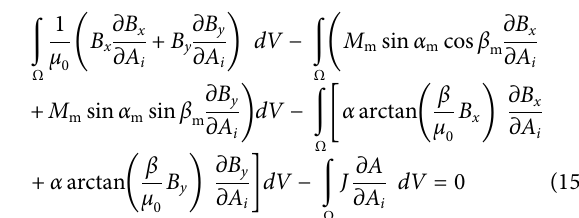
FIGURE 2 | Diagram of the magnetization direction of permanent